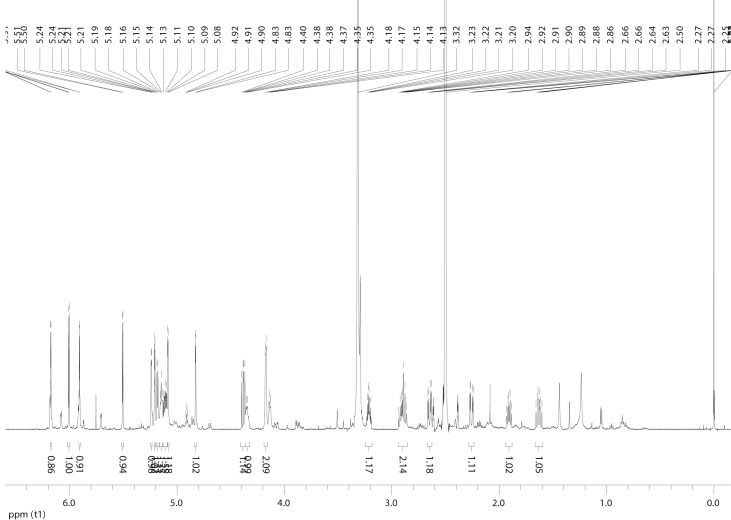
1H NMR (DMSO-d6) spectrum of compound 12.